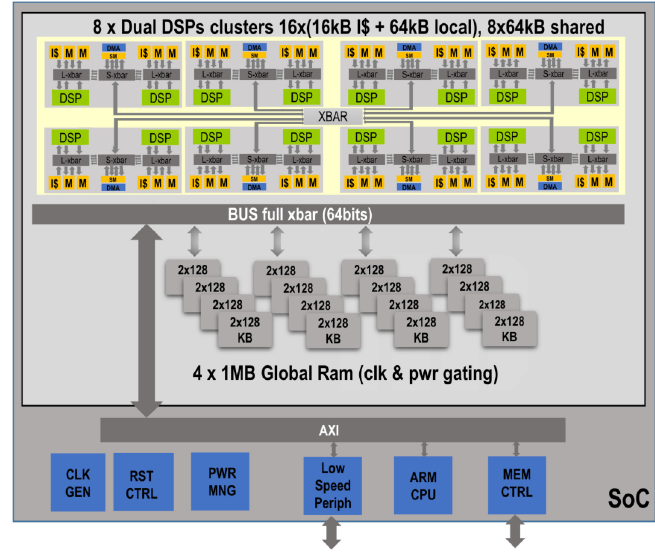
Figure 3. SoC top-level block diagram.